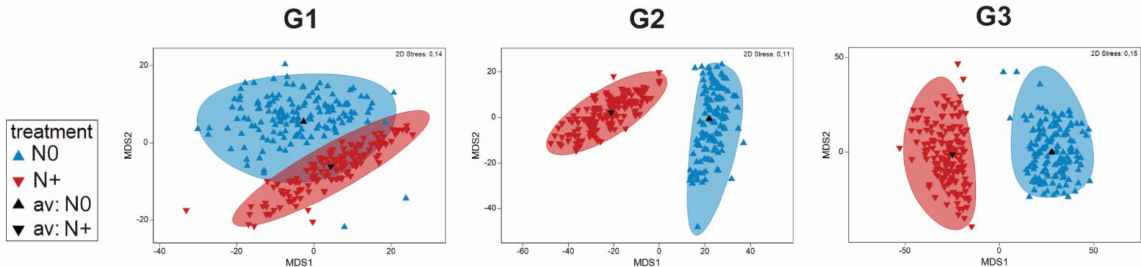
Figure 7. Bootstrap regions for phytoplankton community averages for tanks A1–A3, D1–D3, F1–F3, and G1–G3 plotted in an mMDS plot with 150 bootstraps per group and 95%